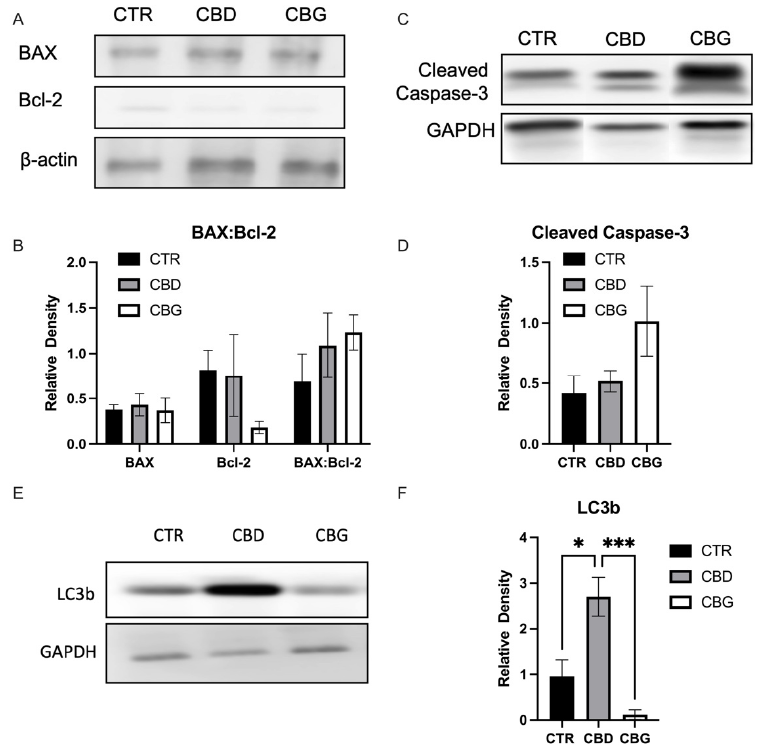
Figure 4. CBD and CBG induces apoptosis in a divergent cell-death pathway in HuCC-T1 cells; ( A ). representative image of Western blotting of BAX (pro-apoptotic) and Bcl-2 (anti-apoptotic) protein and β -actin (reference); ( B ). quantification of the BAX, Bcl-2 and ratio of BAX to Bcl-2; ( C ). representative image of Western blotting of cleaved caspase-3 (Type 1 cell death, apoptosis) and GAPDH (reference) shows trend toward increase in CBG treatment; ( D ). quantification of cleaved caspase-3; ( E ). representative image of Western blotting of total LC3b (Type 2 cell death, autophagy) ( F ). Quantification of total LC3b. * P < 0.05 *** P < 0.001.